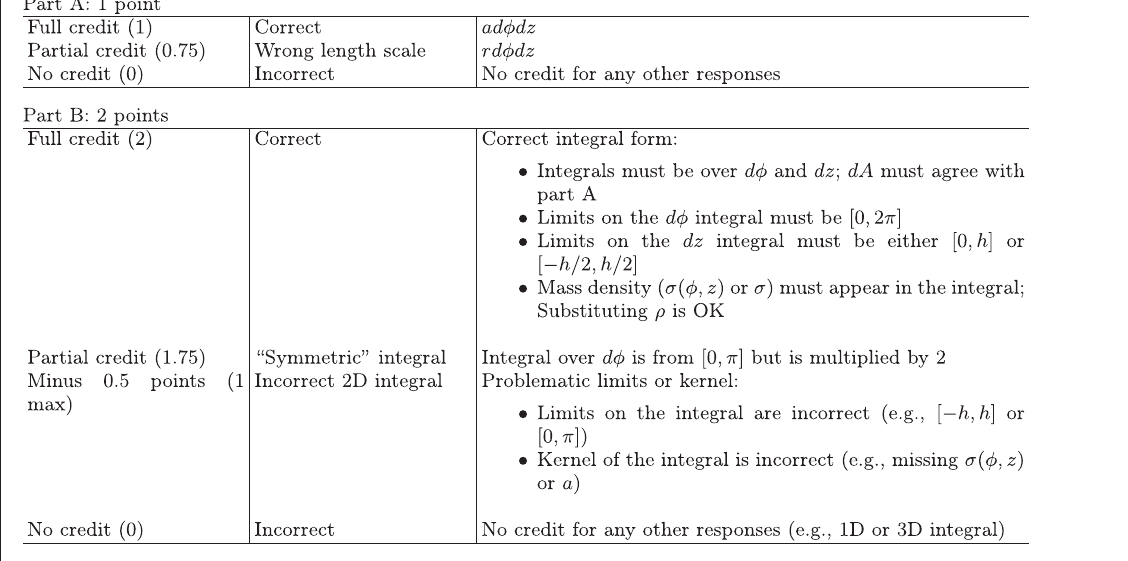
FIG. 2. Grading rubric for the question appearing in Fig. 1. The format focuses the grader ’ s attention on the final response provided by the student. The grading rubric was not designed to elucidate details of student difficulties, but rather to capture the common final responses provided by students and score them accordingly.